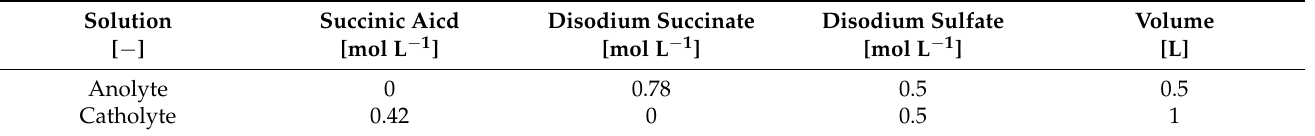
Table 2. Composition and quantity of anolyte and catholyte at the beginning of the crystallization